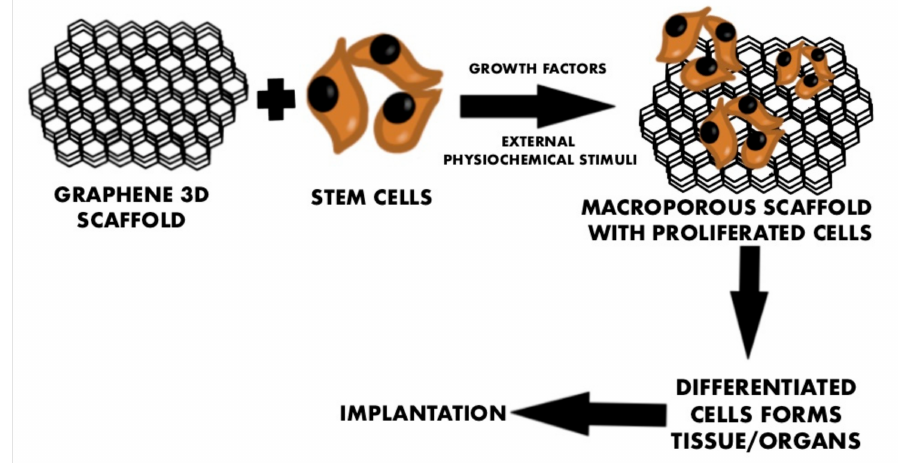
Figure 1. Application of 3D graphene scaffold in tissue engineering of the nervous